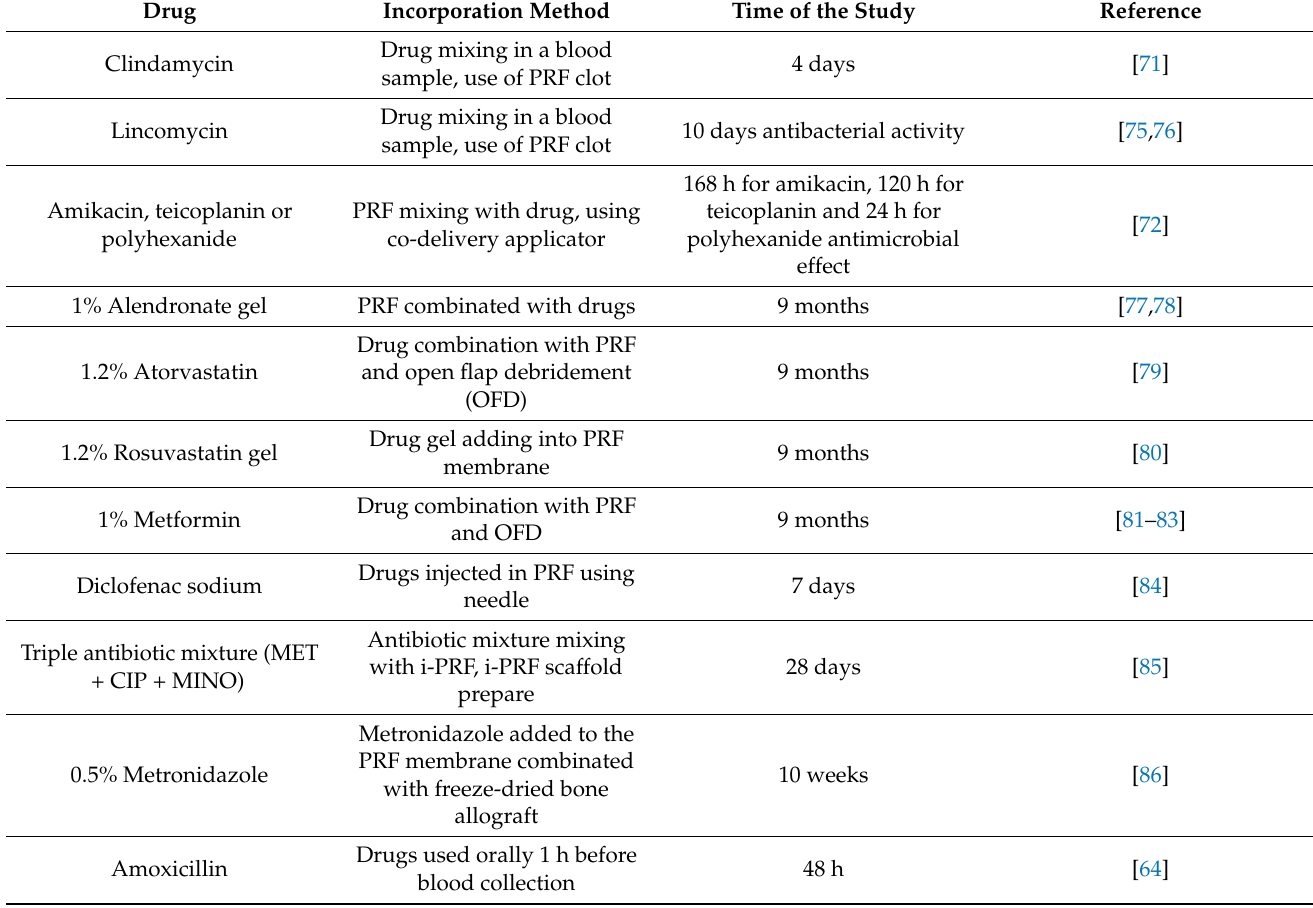
Table 4. Various drugs for inclusion in platelet-rich fibrin system (summary of the drugs in platelet-rich fibrin system).